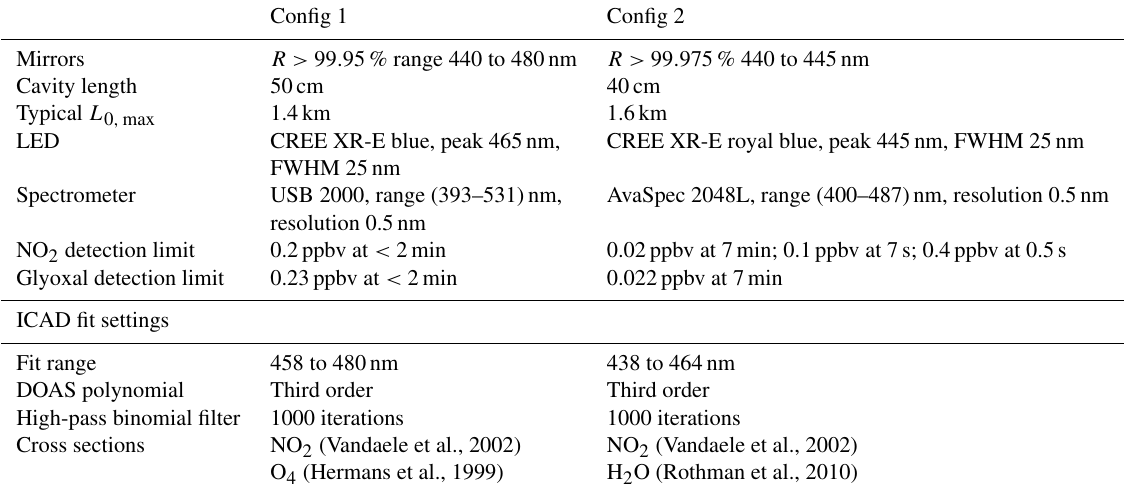
Table 1. Configurations and fit settings of the ICAD NO 2 instrument used in this publication. Glyoxal detection limits were estimated using Volkamer et al. (2005). Glyoxal was removed from the final fits, as it could not be found in the performed test data analysis. Config 1 Config